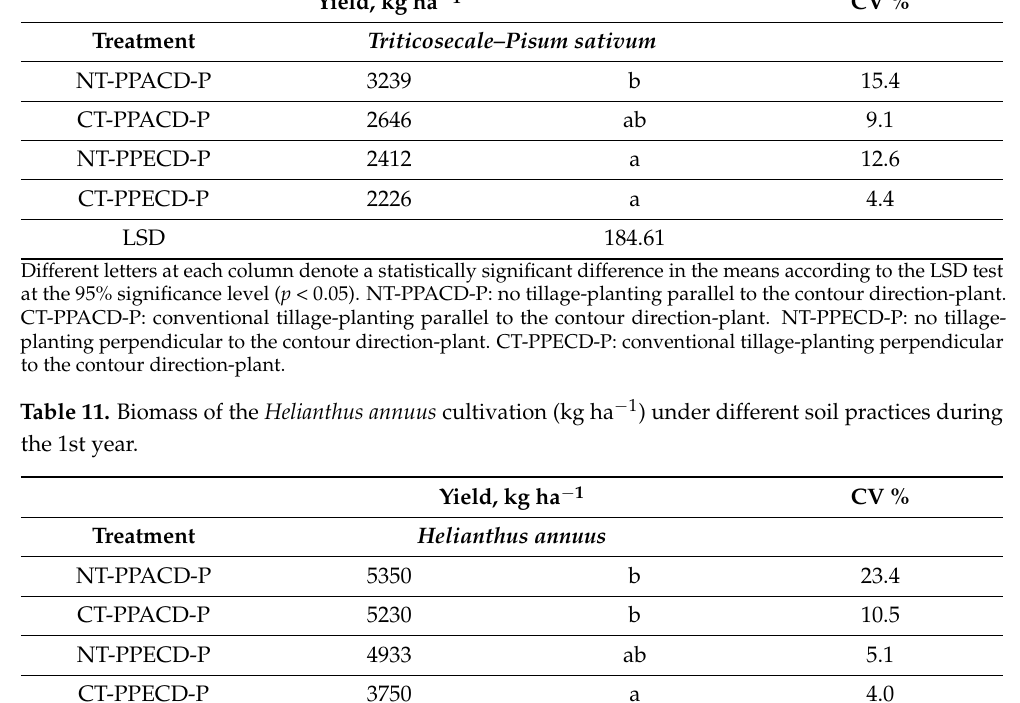
Table 10. Biomass of the intercropping Triticosecale–Pisum sativum cultivation (kg ha − 1 ) under different soil practices during the 2nd year.